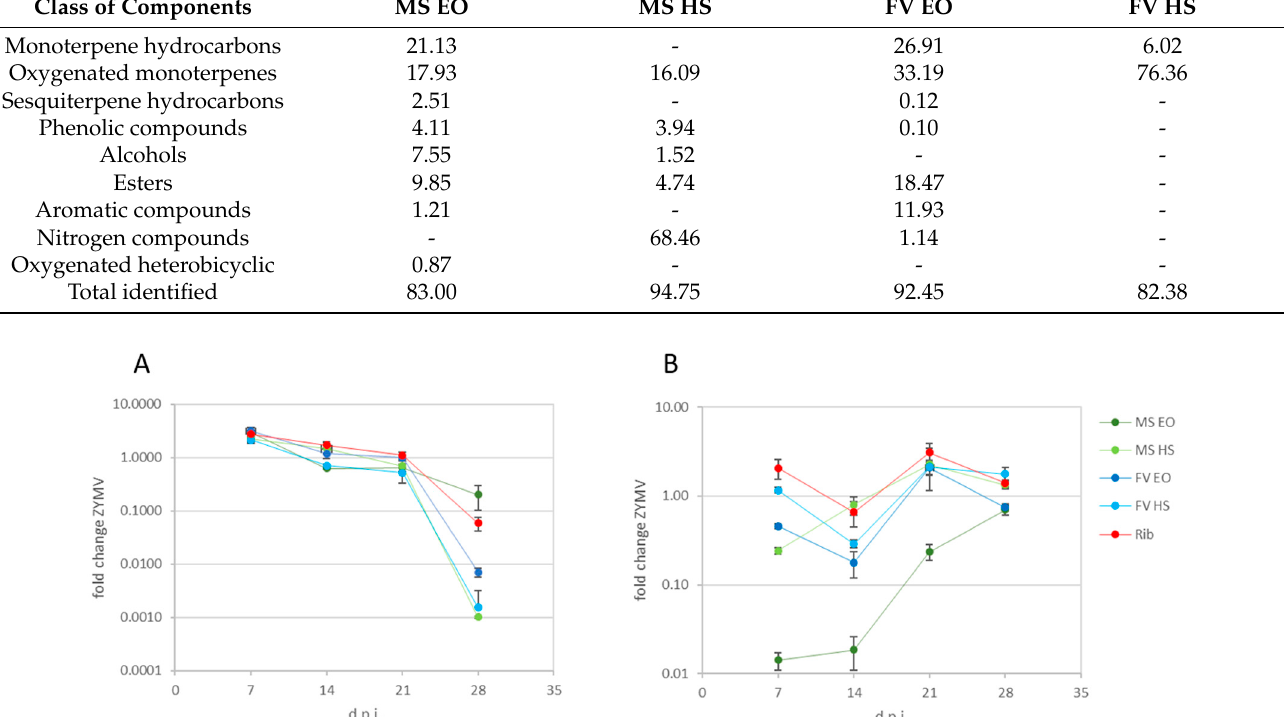
Table 1. Summary of chemical classes retrieved in EOs and HSs used in this study expressed as percentage of the total ion current (TIC) as measured using GC-MS. Values are expressed as means of three chromatographic replicate runs. MS EO = M. suaveolens essential oil; MS HS = M. suaveolens